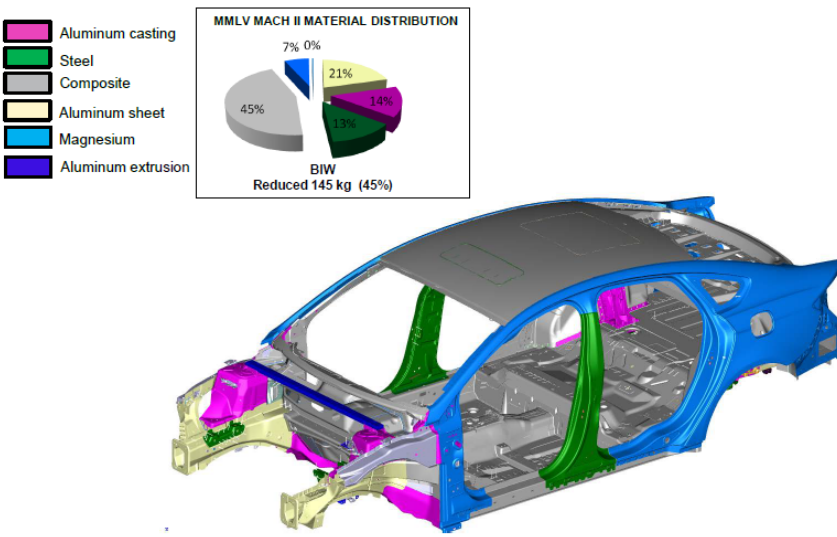
Figure 11. Multimaterial lightweight vehicles MMLV [326].